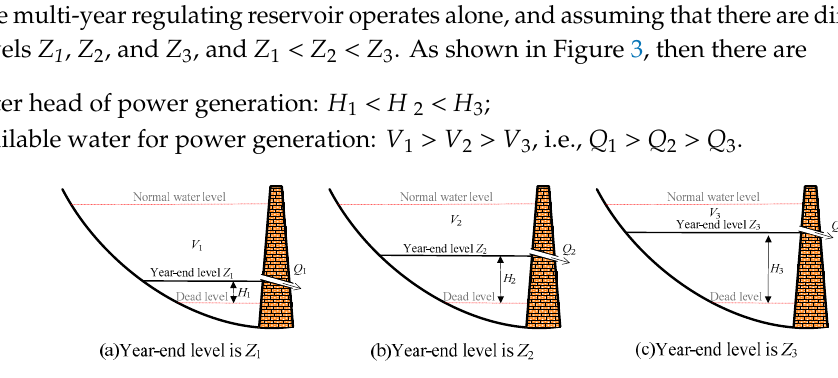
Figure 3. Schematic diagram of different year-end water levels when multi-year regulating reservoir operates alone.